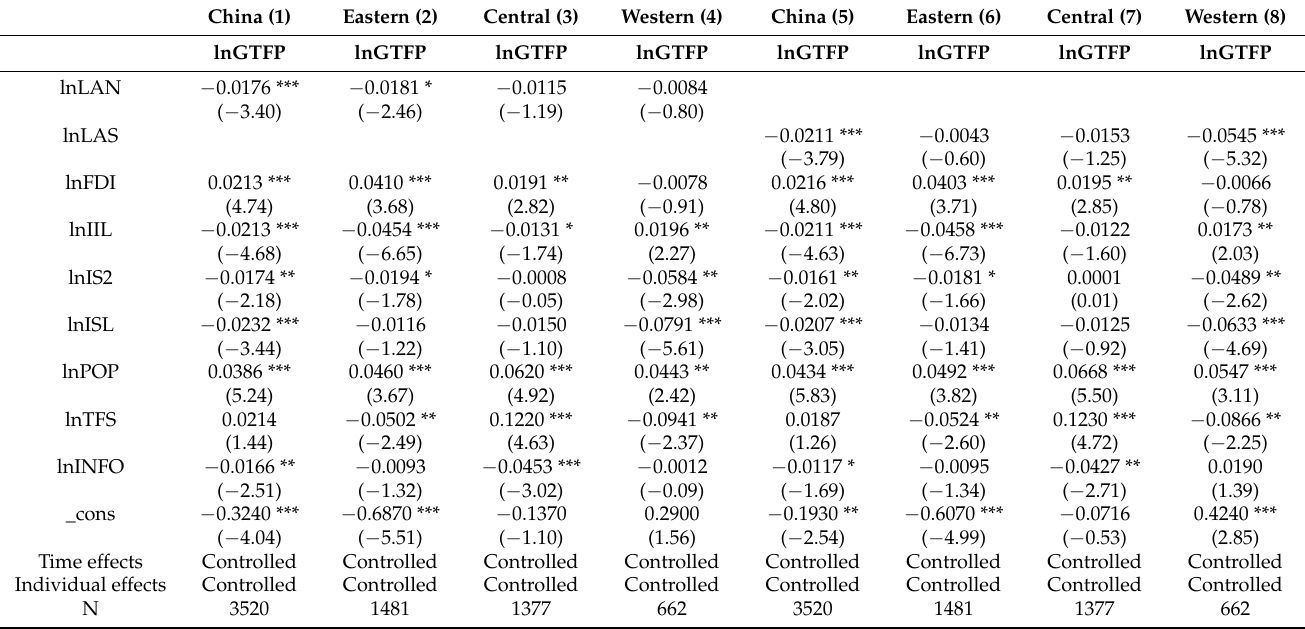
Table 8. Impact of land marketization on urban GTFP (overall and